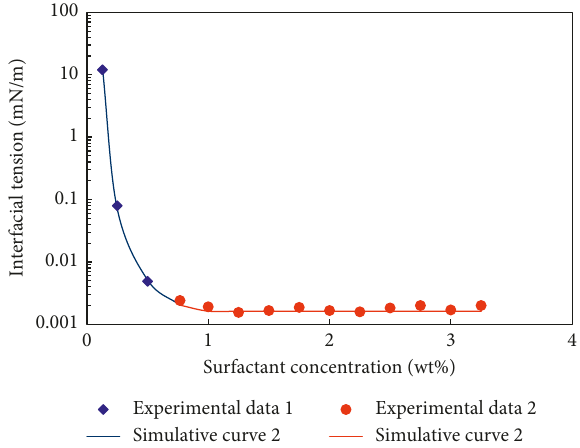
Figure 2: Relationship curve between surfactant concentration and interfacial